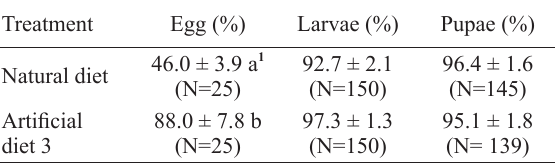
Viability (%) of egg, larval, and pupal stages of Condylorrhiza vestigialis on natural and artificial